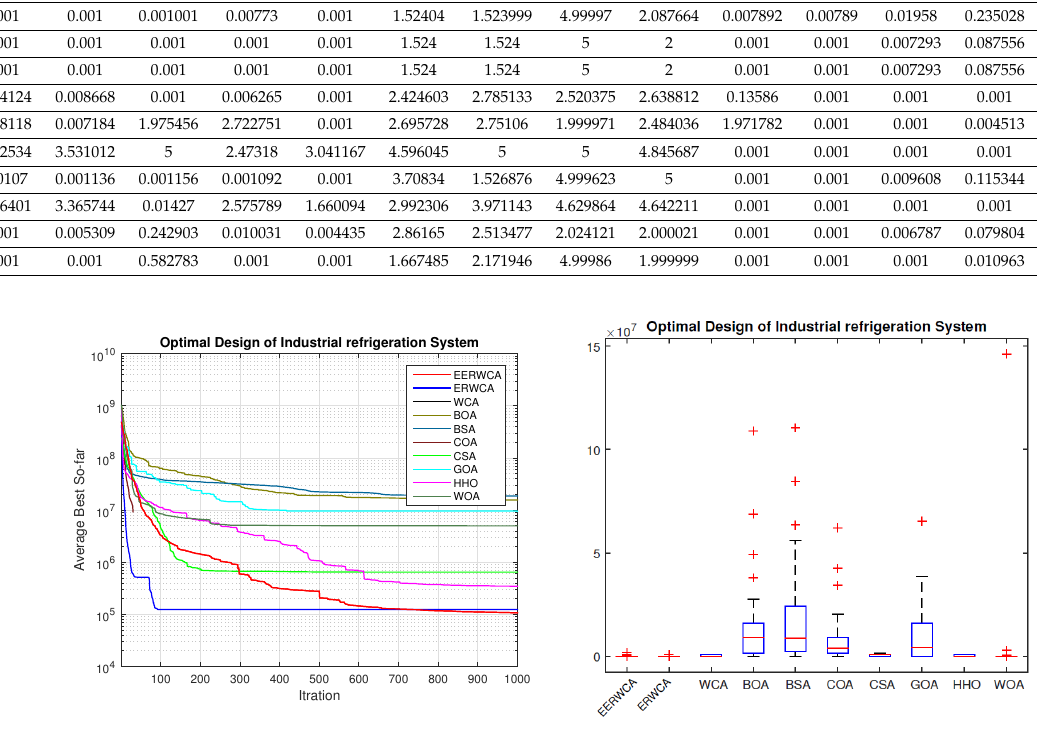
Figure 6. Design of Industrial refrigeration